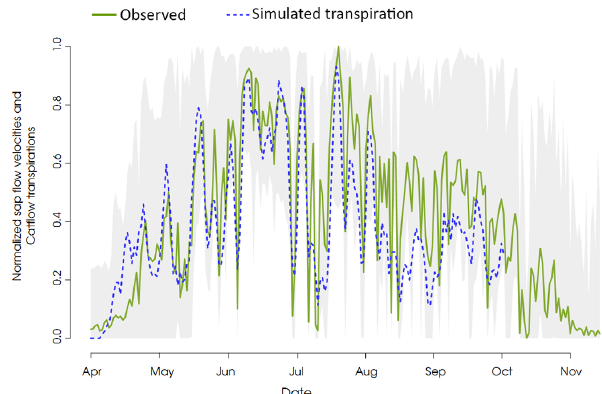
Figure 12. Normalized observed average sap velocities of 28 trees in the Colpach catchment (green) and normalized simulated tran- spiration from the Colpach model smoothed with a 3-day rolling mean (dashed blue). Additionally the ensemble of all 28 sap flow measurements is displayed in